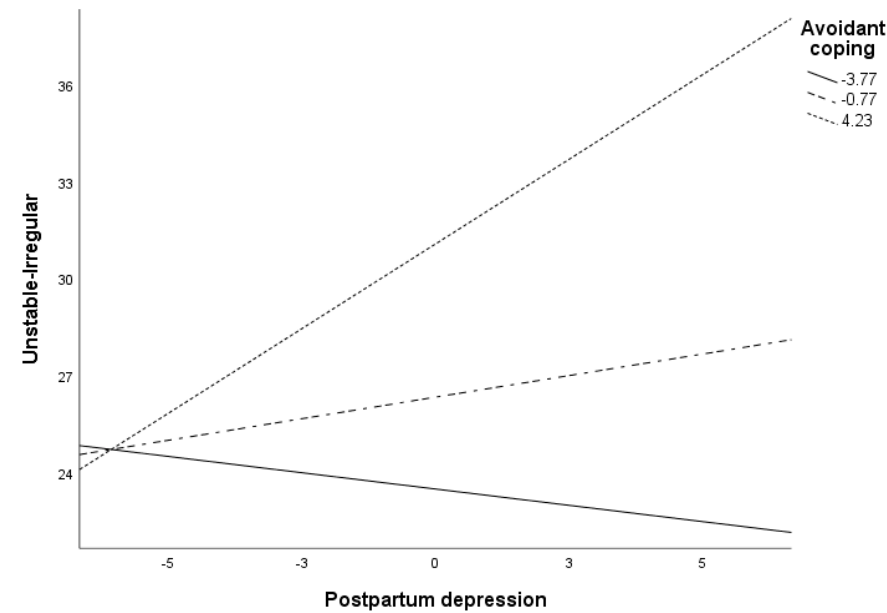
Figure 1. Conditional effects of post-partum depression (PPD) on perception of baby as unstable at values of avoidance.